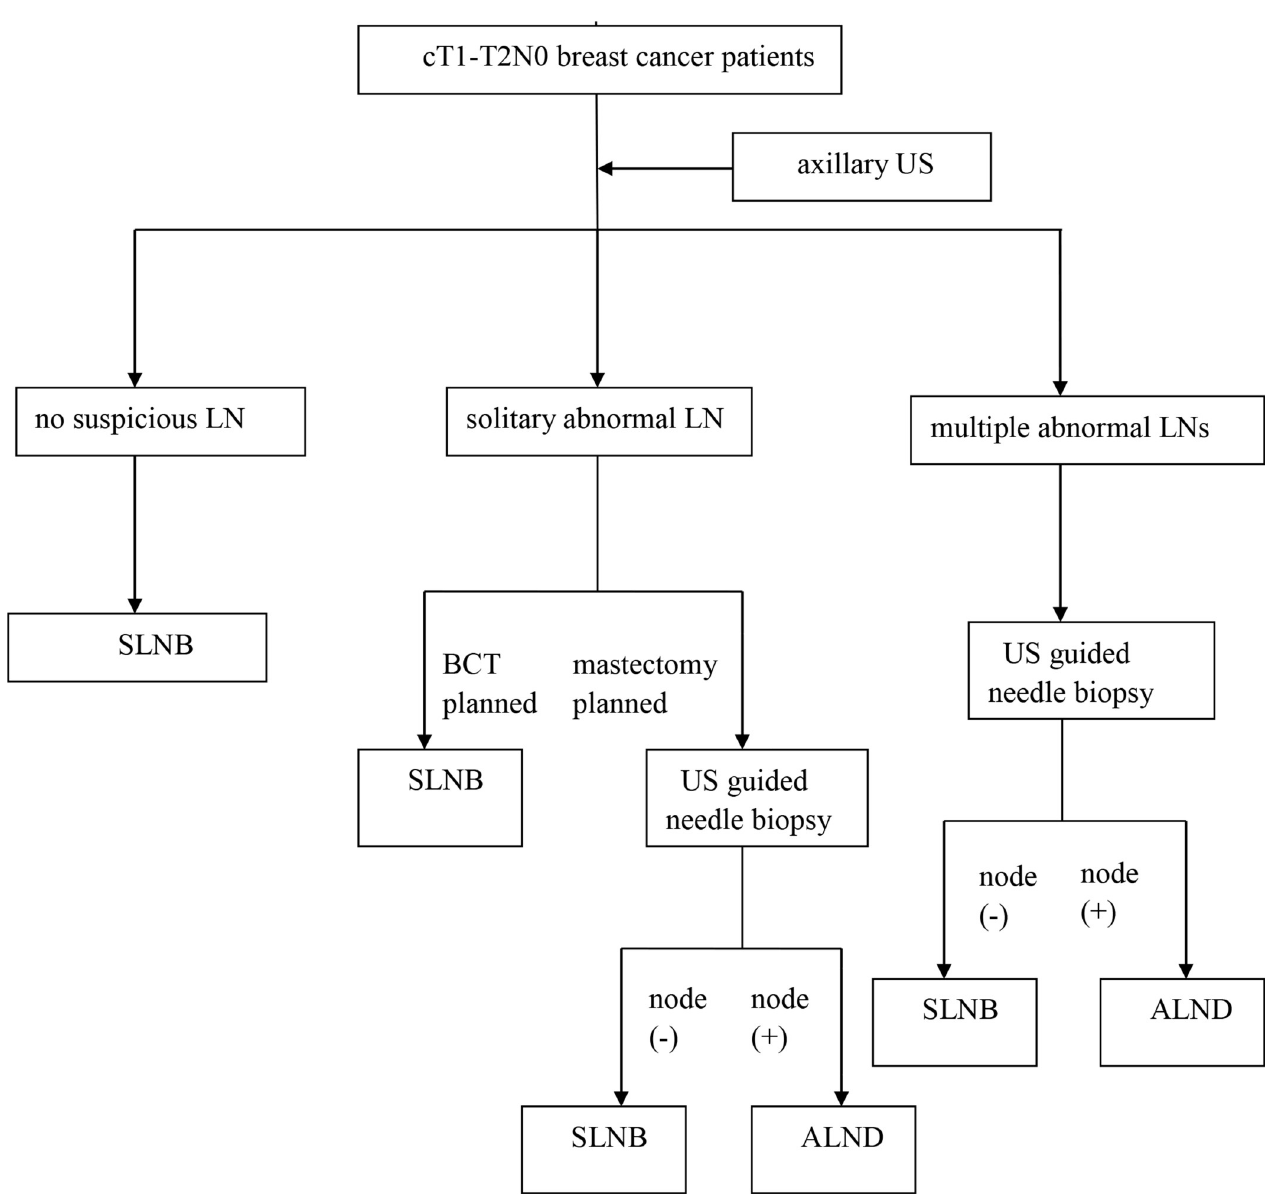
Fig 3. An algorithm for assessment of cT1-T2N0 breast cancer patients with preoperative US.